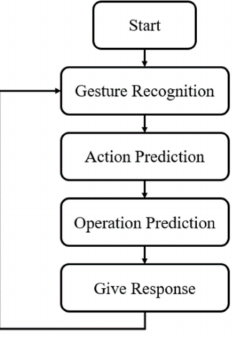
Figure 10. Action and operation prediction in